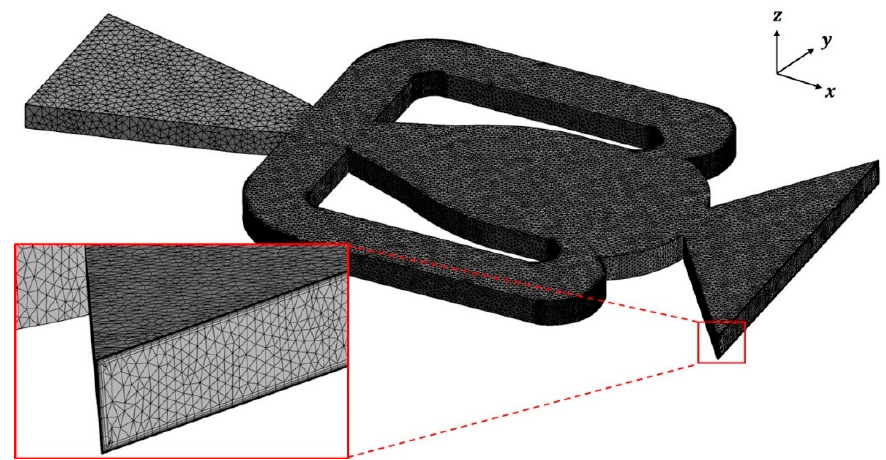
Figure 5. Grid system in the fluidic oscillator.